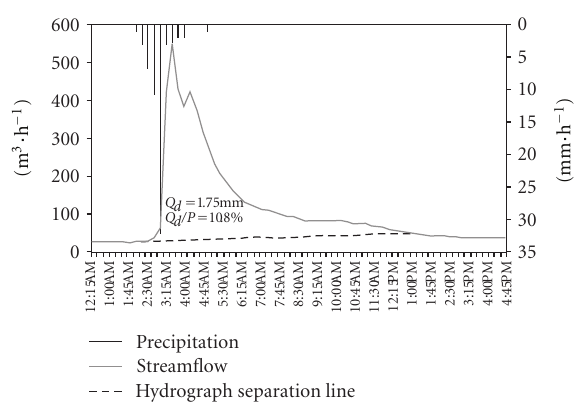
Figure 2: The relation between rainfall and stormflow for a typical selected hydrograph. Qd: direct flow; Qd/P: hydrologic response in terms of percentage o direct flow and precipitation. Table 1: Summarized results of the analysis of rainfall-storm flow of selected hydrographs for the period prior to the clear felling of the old Eucalyptus plantation (Mature forest) and after the clear felling (Young plantation).